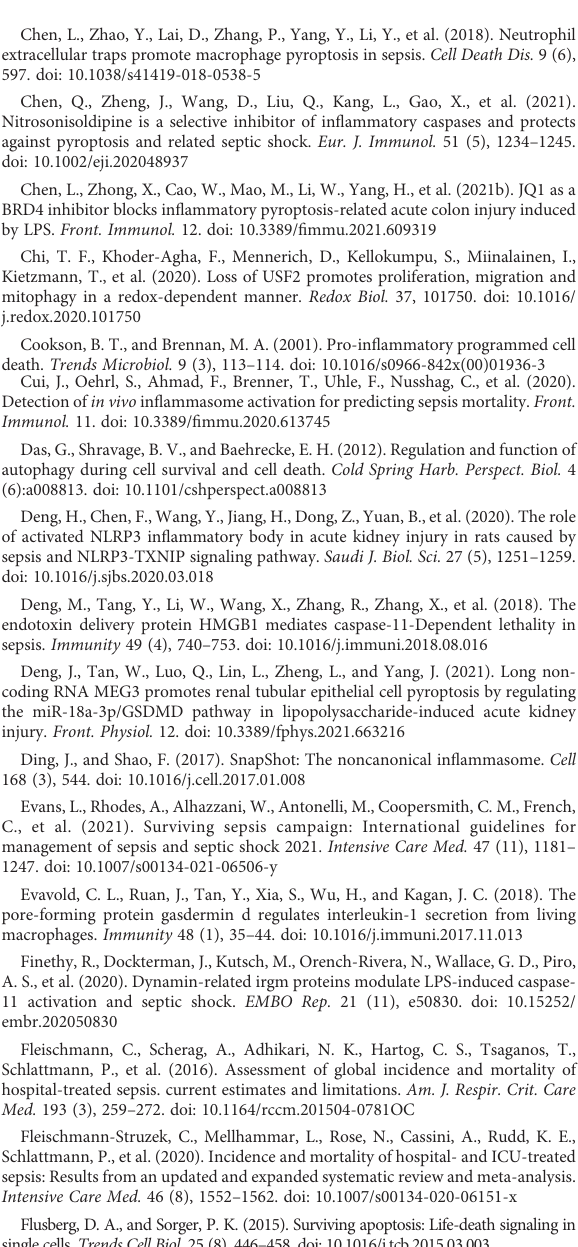
SUPPLEMENTARY FIGURE 1 Expression of the gasdermins family in different